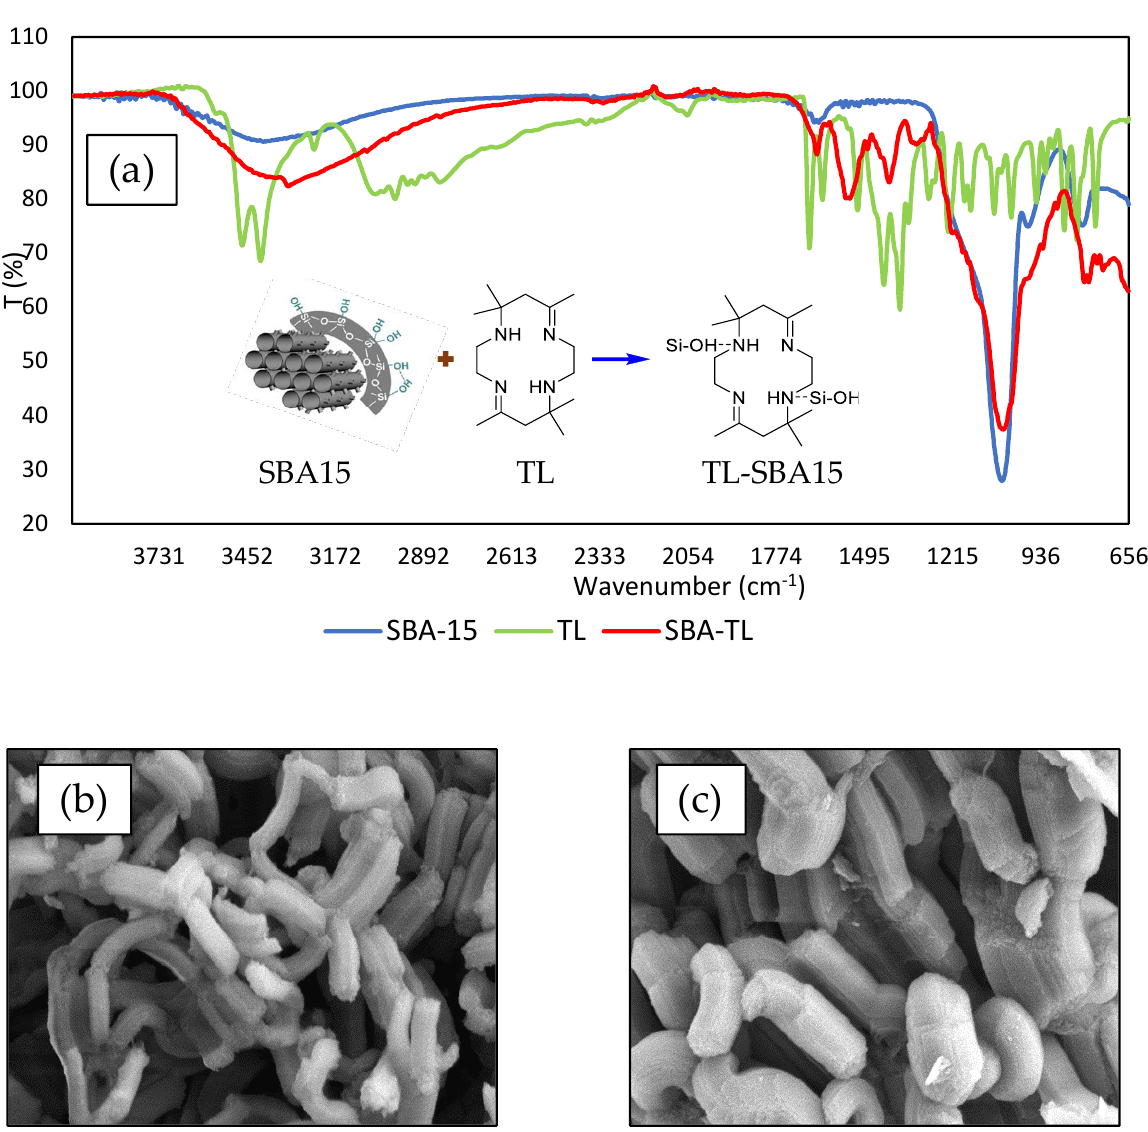
Figure 3. ( a ) FTIR spectra for SBA15, tetraaza compound (TL), and SBA15-TL; ( b ) FESEM micrograph for SBA15; and ( c ) FESEM micrograph for SBA15-TL at 30,000× magnification. The green spectrum represents the TL compound. A strong adsorption band has been observed around 1652 cm − 1 , and it shows the C=N group, while 1220 cm − 1 shows the stretching of the C-N group. Both adsorption bands exist as a result of reaction between ethylenediamine and ammonium bromide to form the TL compound. On top of that, two sharp peaks appear at 3458 and 3396 cm − 1 , which were due to the amine primer group, υ NH. Adsorption band at wavenumber 2894, 2952, and 3000 cm − 1 show the υ N-H stretching group and C-H binding vibration mode. Adsorption bands at 2894, 2952, and 3000 cm − 1 show the υ C-H stretching group and C-H vibration binding mode. After TL was immobilized onto SBA15 (red spectrum), the OH stretching band (~3410 cm − 1 ) of SBA15 becomes broader at a wavenumber of 3000–3500 cm − 1 due to the interaction between the hydroxyl group from SBA15 and the NH group from TL. The imine group C=N stretching band at 1501 cm − 1 of TL becomes stronger and clearer, reaching 1522 cm − 1 , and the hydroxyl peak become broader because of the hydrogen bonding interaction between the nitrogen of the imine from TL with the hydrogen of SBA15 [32]. There was a hydrogen-bonding interaction between the nitrogen of the imine with